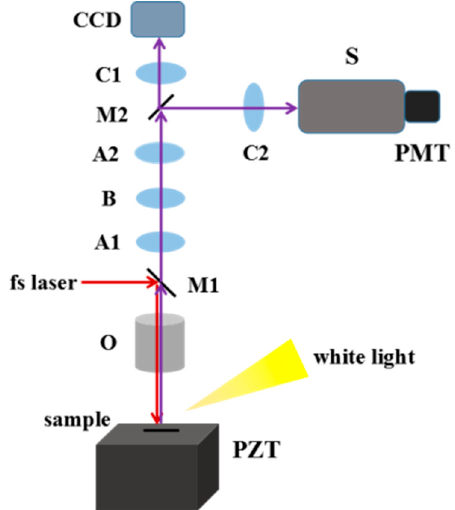
Figure 1. The experiment optical path of photoluminescence test system. PZT, piezoelectric ceramic transducer; O, objective; A, half-wave plate; B, polarizer; C, low pass filter; M, reflector; CCD, charge couple device; S, spectrometer; PMT, photomultiplier tube.